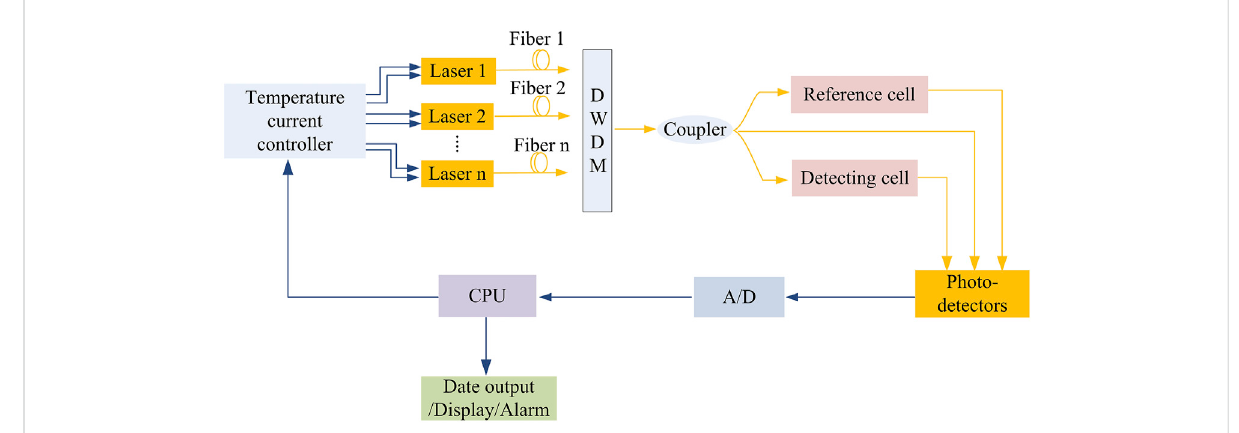
FIGURE 8 Block diagram of TDLAS-based multi-gas sensor system.